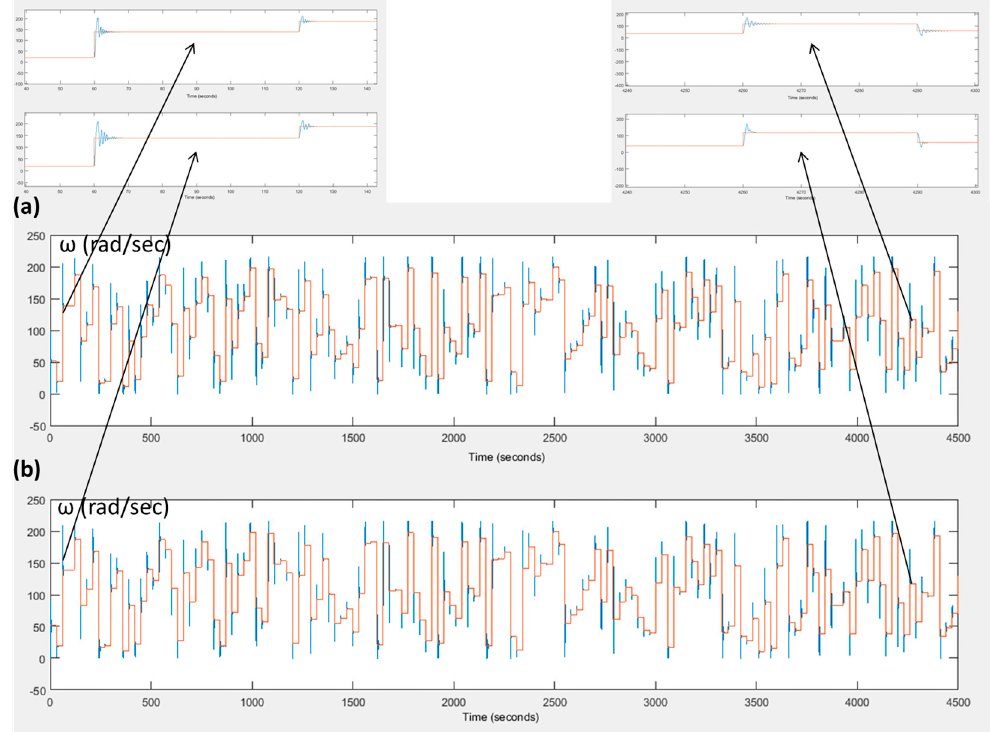
Figure 4. ( a ) Velocity of DC motor ( ω ) with conventional PID control strategy (blue line) and velocity set point (red line), and ( b ) velocity of DC motor ( ω ) with fuzzy Q-Learning PID control strategy (blue line) and velocity set point (red line).